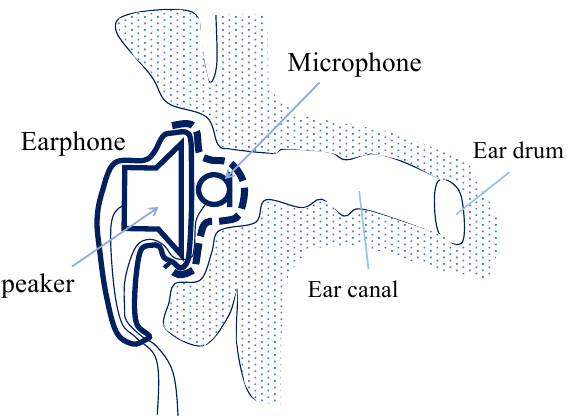
Figure 1. Sketch of outer ear with measurement device (earphone with microphone) for identification of ear canal